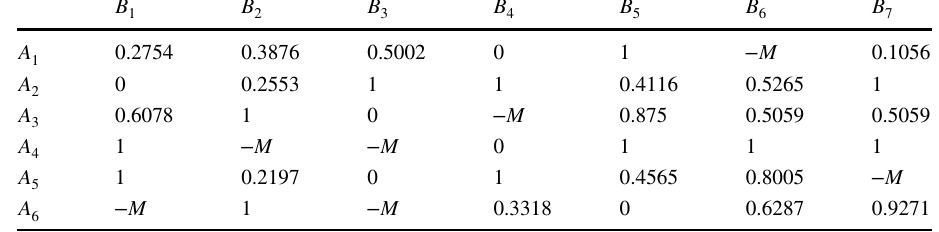
Table 8 Perceived value matrix Y = ( y ) 6 ij × 7